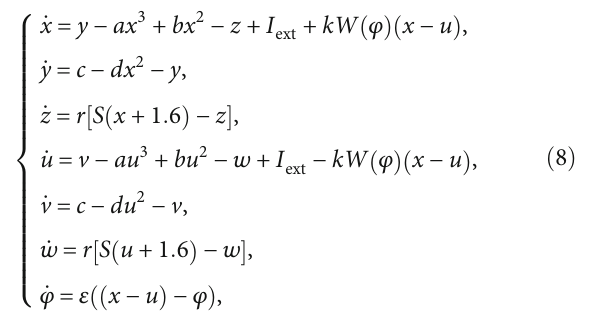
, A , and A are three 1 2 3